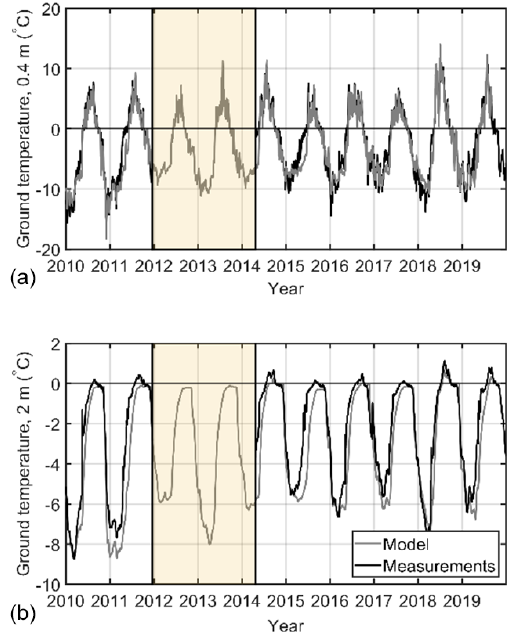
Figure 3. Modelled and measured ground temperature at the PACE borehole in Juvvasshøe at 0.4 (a) and 2.0m (b) depth. The shaded area indicates a period when no borehole data are available.